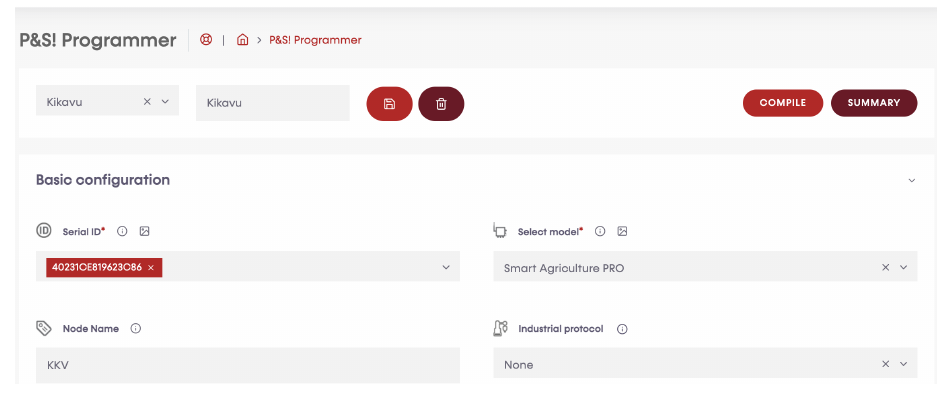
Figure 8. Device selection using serial number.